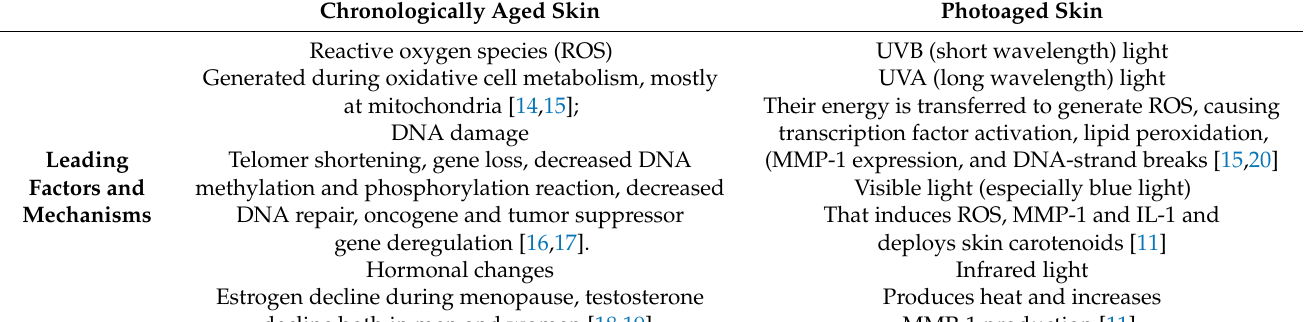
Table 1. Causes and consequences in chronologically and photoaged